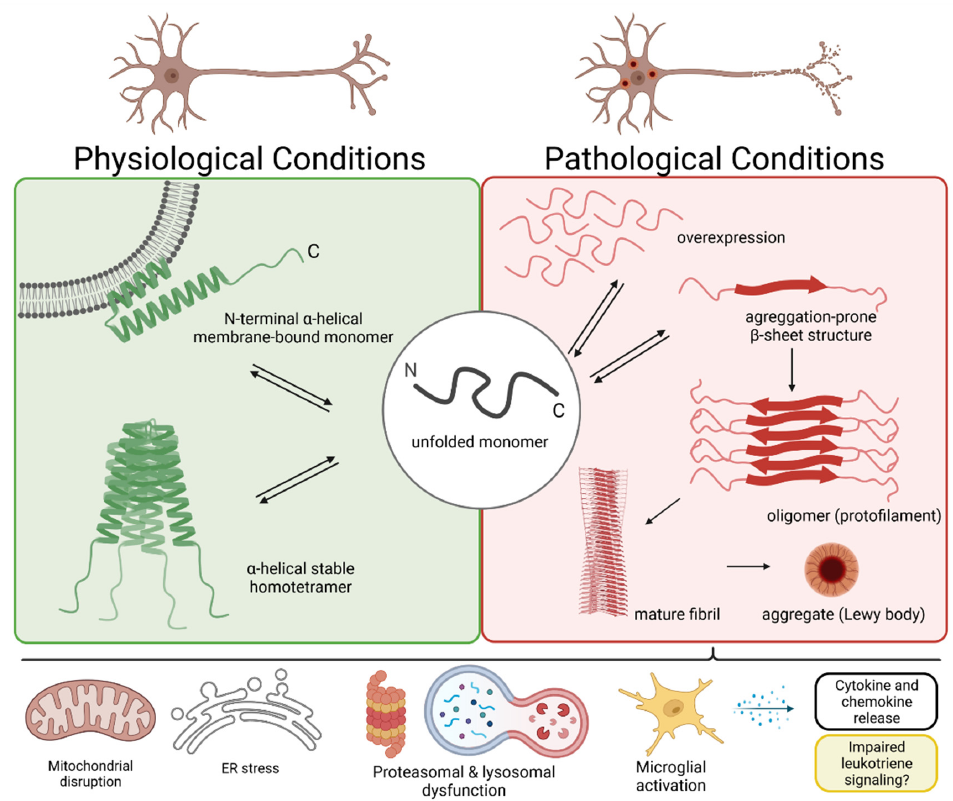
Figure 2. Structural features of functional and dysfunctional α -synuclein. Physiologically, α -synuclein likely exists in a dynamic equilibrium between an unfolded monomer and an α -helical membrane-bound or homotetrameric structure. Both the overexpression as well as the conformational change into a β -sheet structure increase the susceptibility of α -synuclein to accumulate. The aggregation process involves the formation of oligomeric protofilaments, which mature to fibrils and associate with other proteins to build up Lewy bodies. Under pathological conditions, aggregates of α -synuclein and Lewy bodies interfere with a variety of cellular processes, including mitochondrial and endoplasmic reticulum functions, protein degradation systems as well as with the activation state of microglia. Together, the disruption of cell homeostasis and the proinflammatory response of microglia (via releasing cytokines, chemokines and/or leukotrienes) eventually lead to neuronal cell damage and death. Created with BioRender.com (last accessed on 4 November 2021).